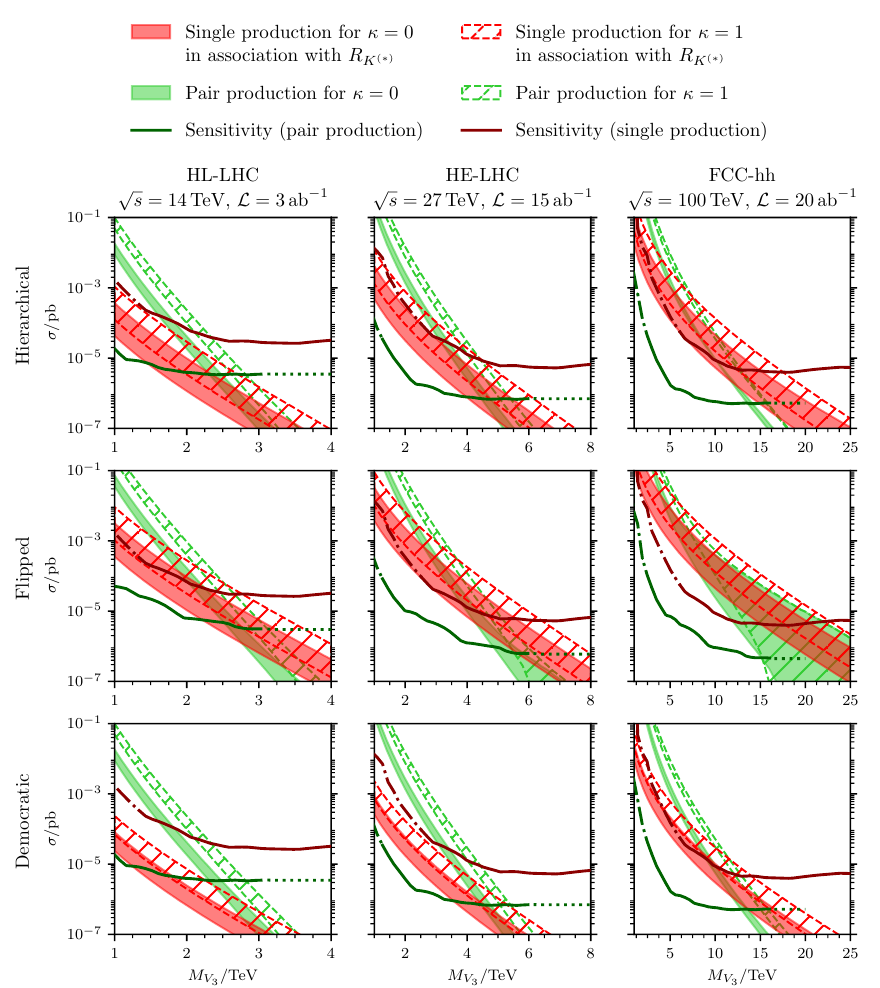
Figure 5 . V 3 -leptoquark production in pp -collisions in the flavor scenarios introduced in section 2.2 (rows) for different future collider experiments (columns). Red bands: single production cross section for σ ( pp → µ + µ − j ) induced by the triplet V 3 , derived from the R K,K ∗ -band in eq. (2.10) for hierarchical and flipped scenarios, and eq. (2.13) for the democratic scenario. Light green: pair production with final states ( bµ, bµ ) for the hierarchical and democratic scenarios and ( cµ, cµ ) for the flipped scenario. The error bands for pair production are evaluated by combining the pdf-, and scale uncertainties, see figure 4 and section 3.5 for the